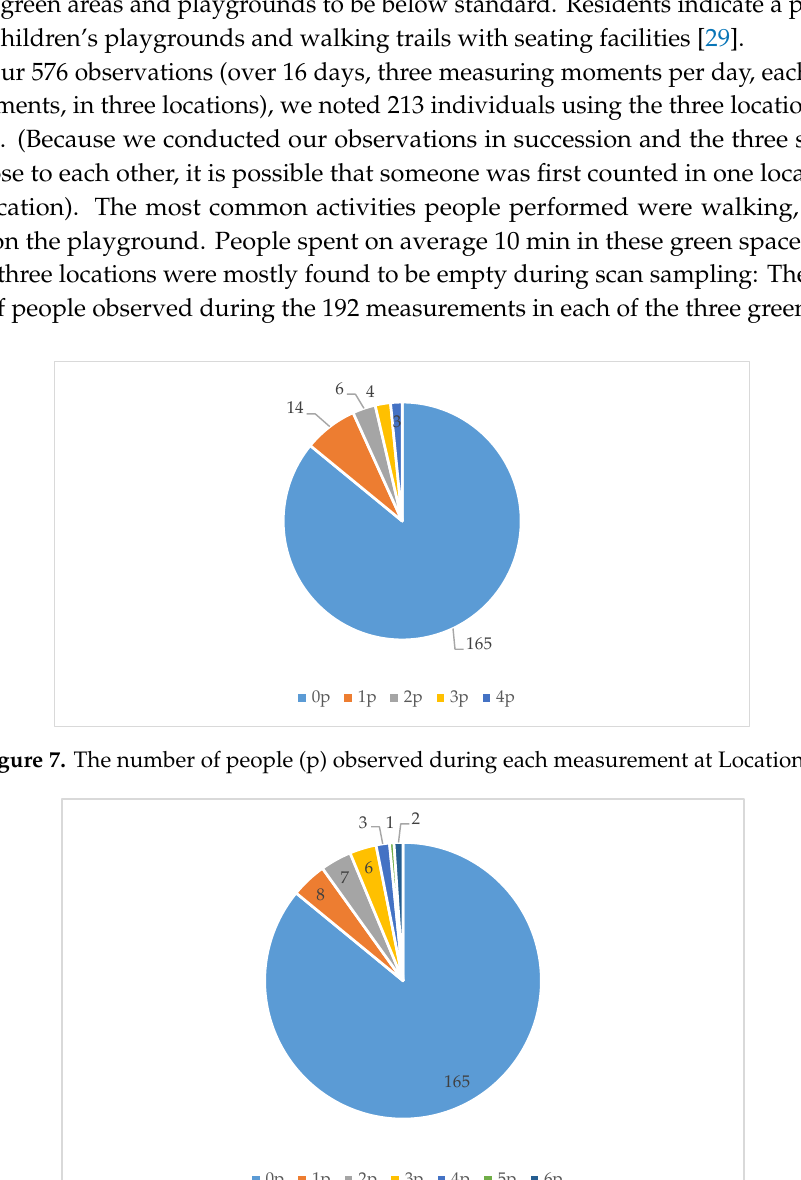
Figure 9. The number of people observed during each measurement at location 3.